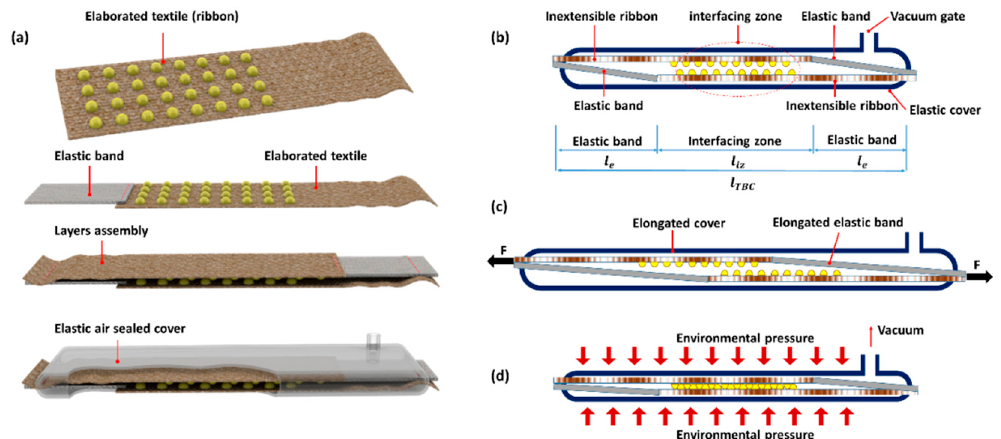
Figure 1. ( a ) CAD presentation of our textile-based clutch (TBC); two layers of textile parallel to each other are placed inside an elastic cover. ( b , c ) Textile layers can slide in front of each other by means of an external elongation force; an elastic element in each layer of textile enables the device to elongate and recover its initial configuration. ( d ) Connecting the TBC to a vacuum source enables the elaborated layers to create a temporary adhesion, which blocks the elongation of the TBC under external elongation forces.